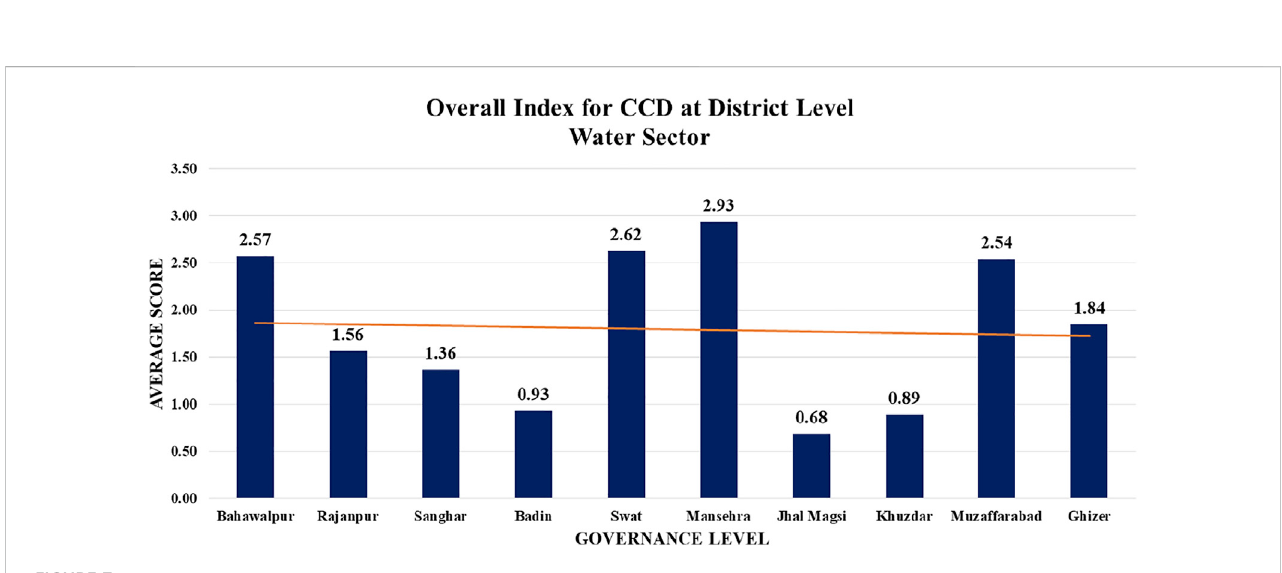
FIGURE 7 State of water sector governance in a local